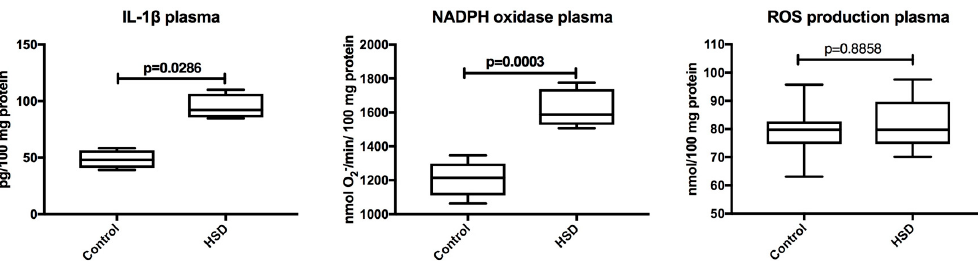
Figure 4. The effect of a high-sucrose diet (HSD) on plasma inflammation and reactive oxygen species (ROS) production. Abbreviations: IL-1 β , interleukin-1 β , ROS, reactive oxygen